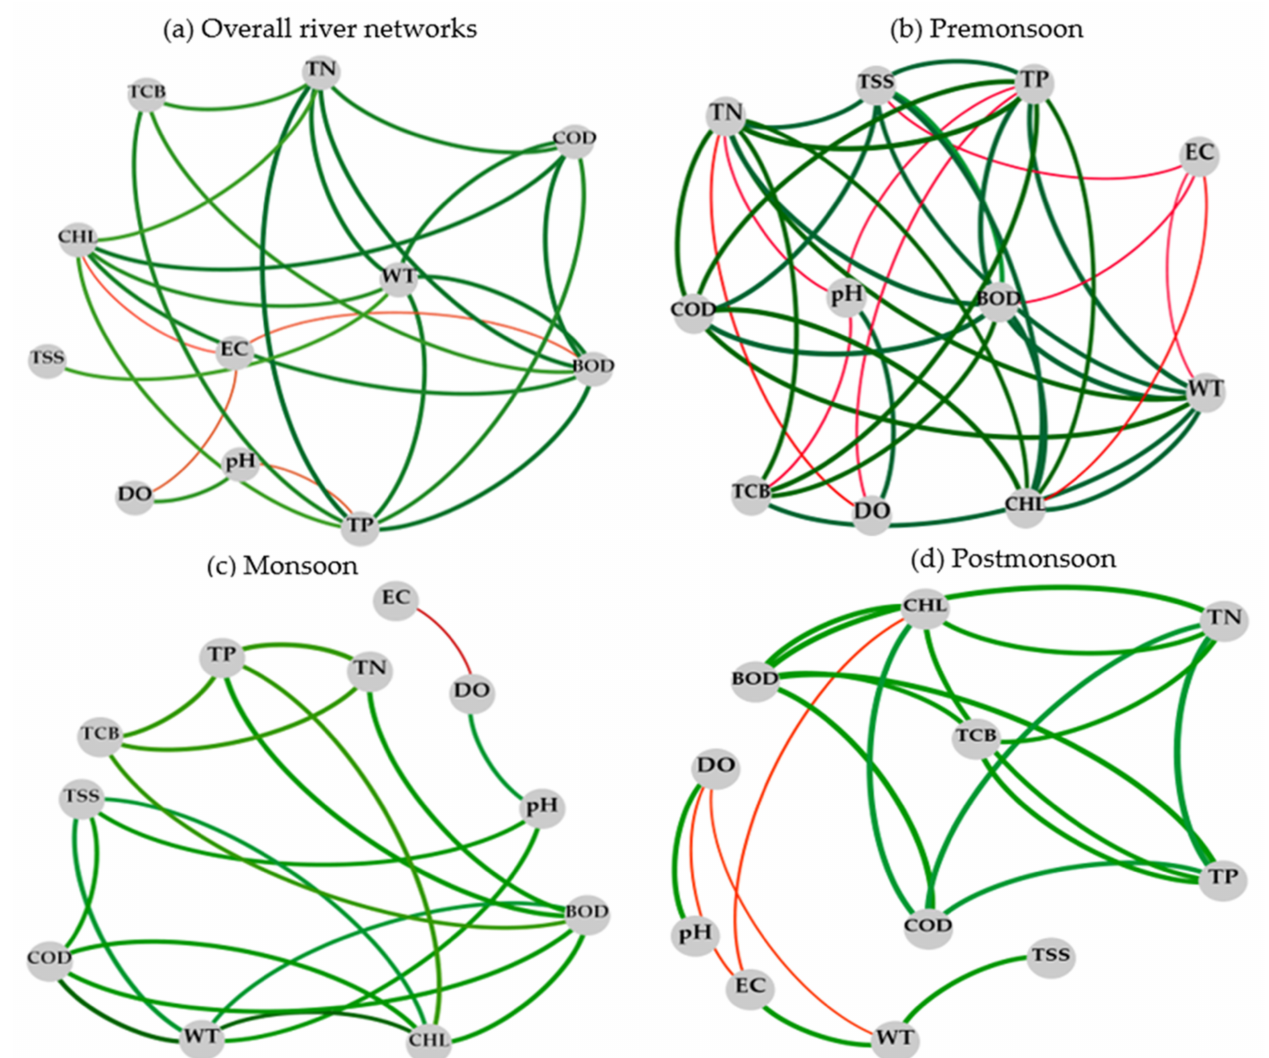
Figure 4. Co-occurrence correlation networks of water quality variables at spatial and temporal scales in the river (pH: hydrogen ion concentration; WT: water temperature; DO: dissolved oxygen; EC: electrical conductivity; TSS: total suspended solids; TP: total phosphorus; TN: total nitrogen; BOD: biological oxygen demand; COD: chemical oxygen demand; CHL- a: chlorophyll-a; TCB: total coliform bacteria; ( a ) overall river networks: from S1–S16; ( b ) premonsoon: January–June; ( c ) monsoon: July–August; ( d ) postmonsoon: September–December; red line indicates negative relation and green line indicates positive